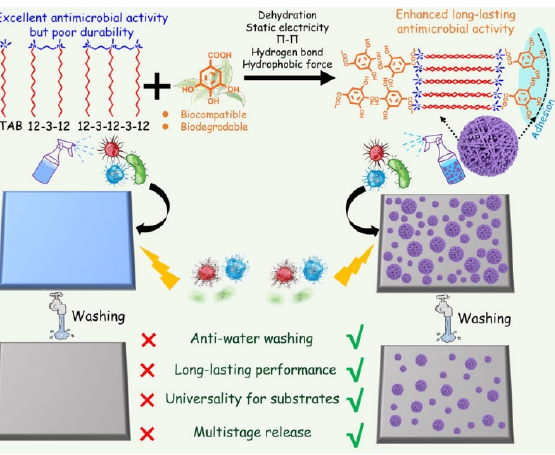
Figure 5. Construction of substrate-adhesive aggregates (hexagonal columns interpenetrated spheres, HCISs) based on noncovalent assembly of gallic acid (GA) and three quaternary ammonium surfac- tants (QASs). Reprinted with permission from Ref. [73]. Copyright 2021,